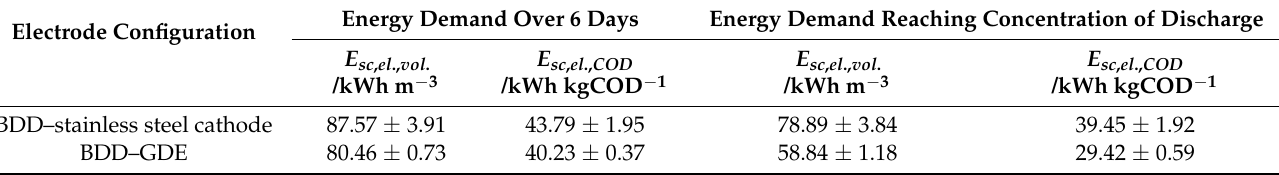
Table 1. Energy demands of the investigated electrolysis setups for COD removal at room temperature. Energy Demand Over 6 Electrode Configuration